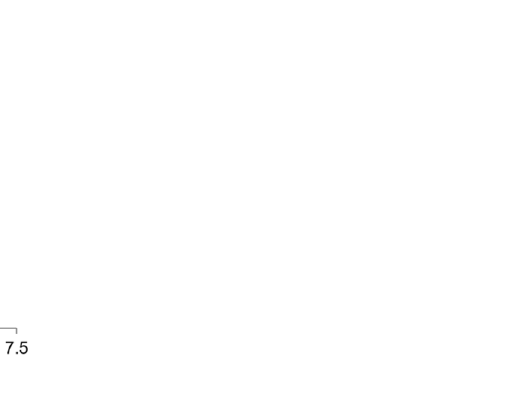
Figure 4. Effect of pH on the fluorescence intensity of BRhoC (8.7 μ M) in a 10 mM HEPES aqueous solution.